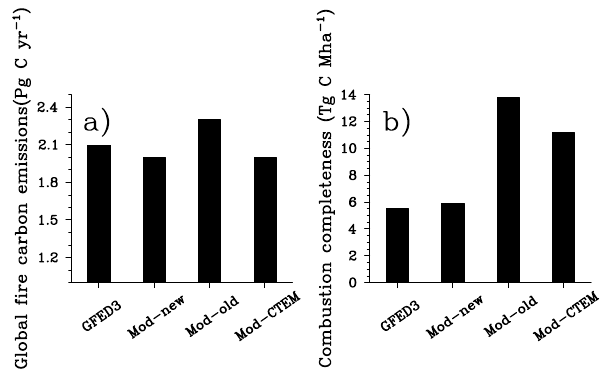
Fig. 14. 1997–2004 average (a) global annual fire carbon emissions and (b) combustion completeness in global post-fire regions.